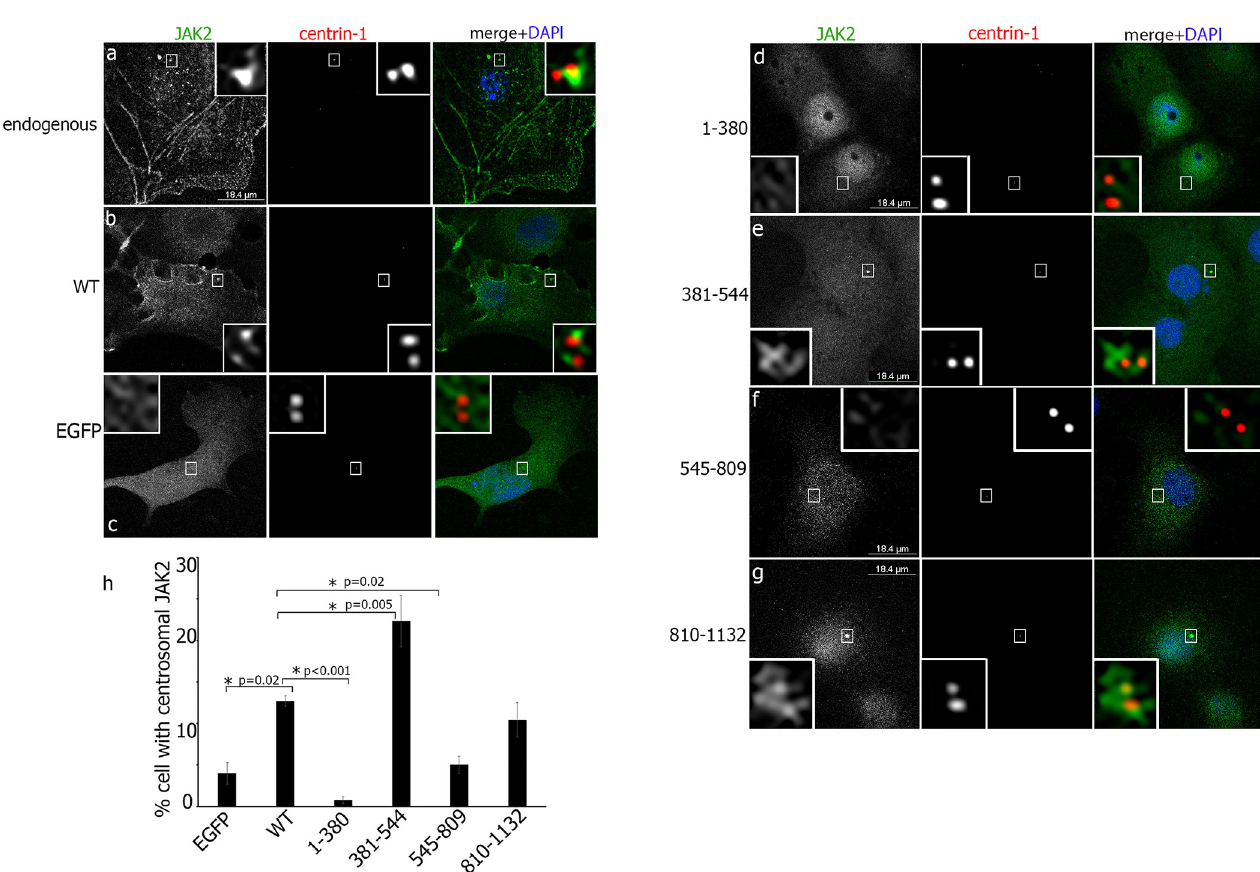
Fig 2. Centrosomal localization of JAK2 depends on both the SH2 domain and the intact kinase domain. COS-7 cells transiently overexpressing EGFP ( c ), WT ( b ) or the indicated forms of EGFP-JAK2 ( d-g ; green or yellow in the merged image) were immunolabeled with anti-centrin-1 AB (red in the merged image). DAPI stains cell nuclei (blue in the merge image). Anti-JAK2 AB were used to localize the endogenous JAK2 in non-transfected COS-7 cells ( a ) The insets show enlarged centrosomes. ( h ) The number of EGFP-positive cells with centrosomal JAK2 were scored and plotted. 50 cells were assessed in each experiment for each type of transfection. N = 9 for EGFP-expressed cells, n = 6 for WT and (381–544) mutant, n = 8 for (1–380) and (545–809) mutants and n = 7 for (810–1132) mutant. Bars represent mean ± SE. � , P < 0.05 compared with WT cells.